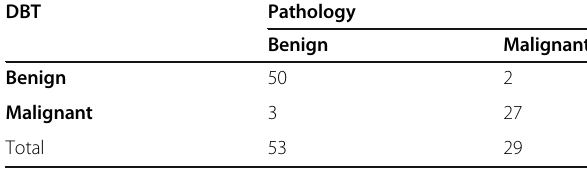
Table 3 Correlation between DBT results and pathology